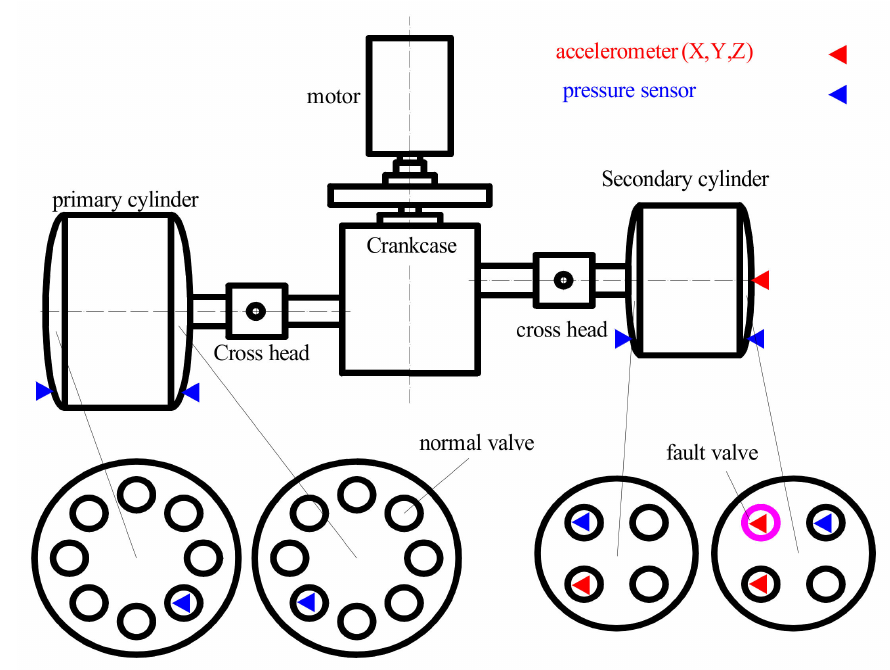
Figure 9. No.1 structure and two-stage gas valve measuring point